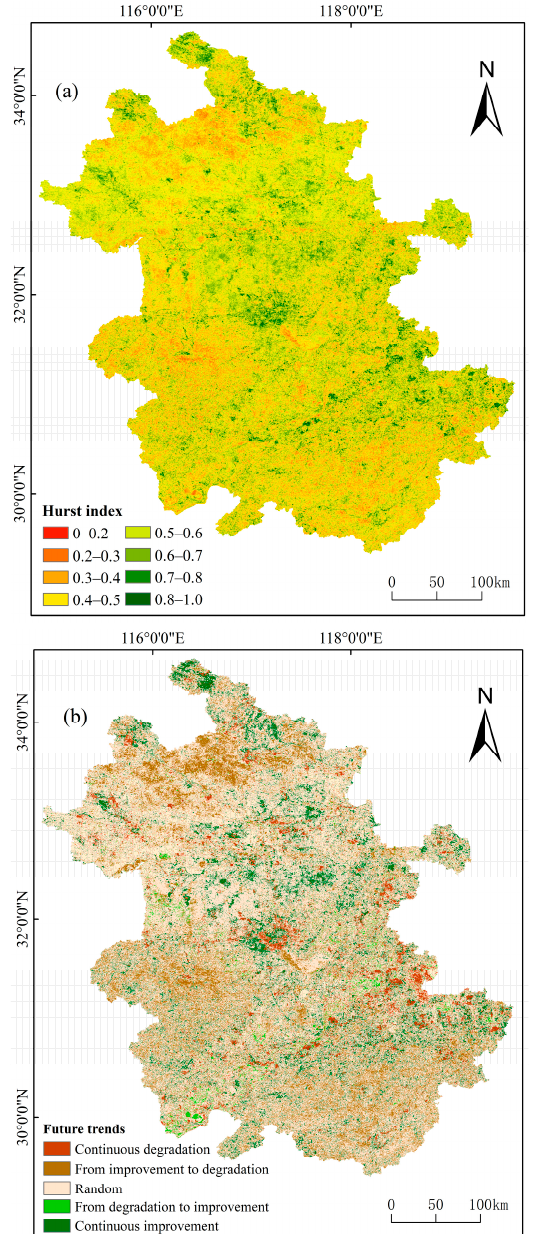
Figure 7. Spatial distribution and variation trend prediction of Hurst index in Anhui Province from 2001 to 2019: ( a ) spatial distribution of Hurst index, its value ranged from 0.11 to 1; ( b ) variation